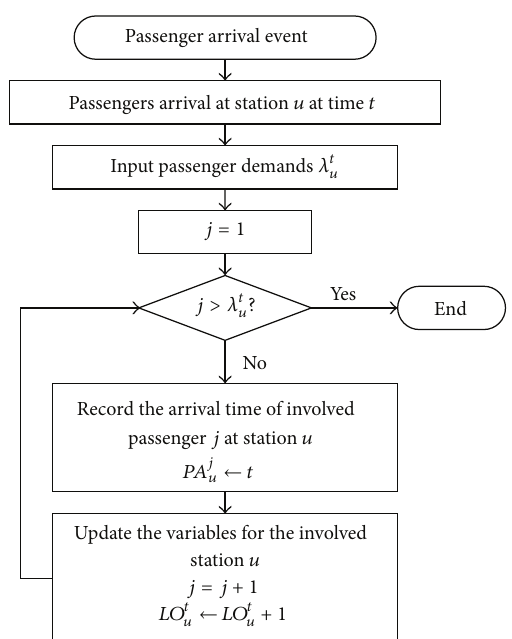
Figure 3: Flowchart of passenger arrival